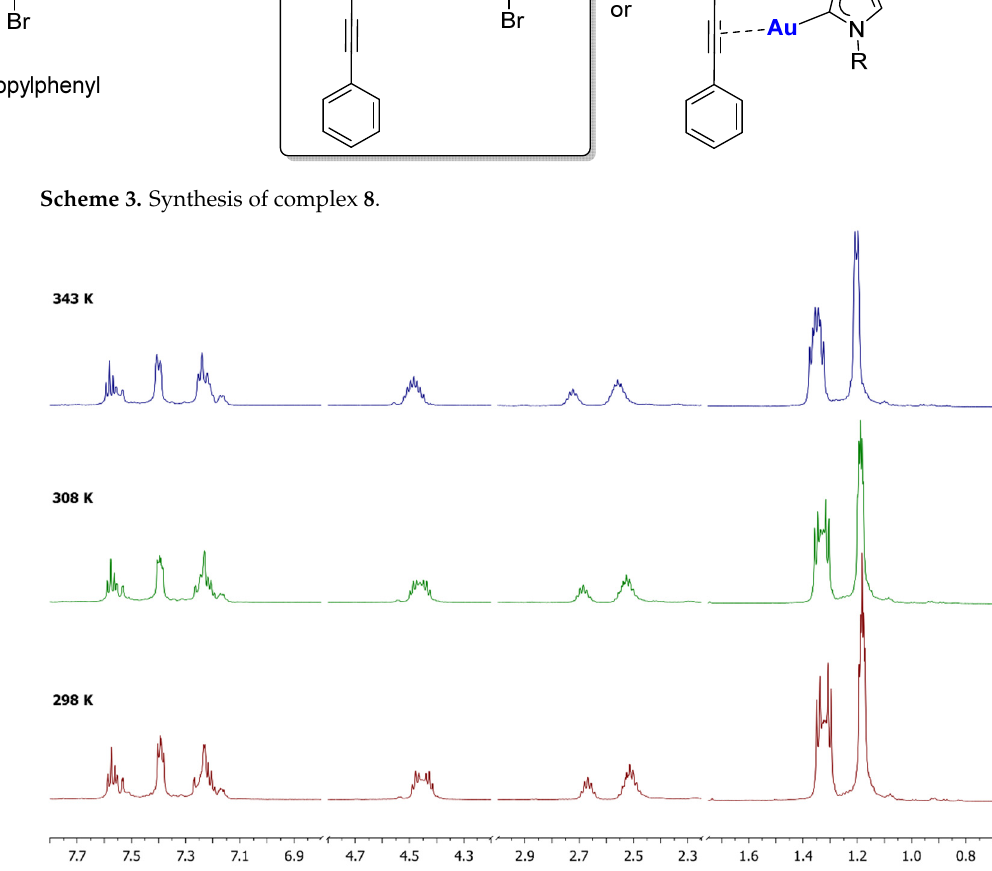
Figure 2. 1 H-NMR spectra of complex 8 in CD 3 CN at different temperatures.